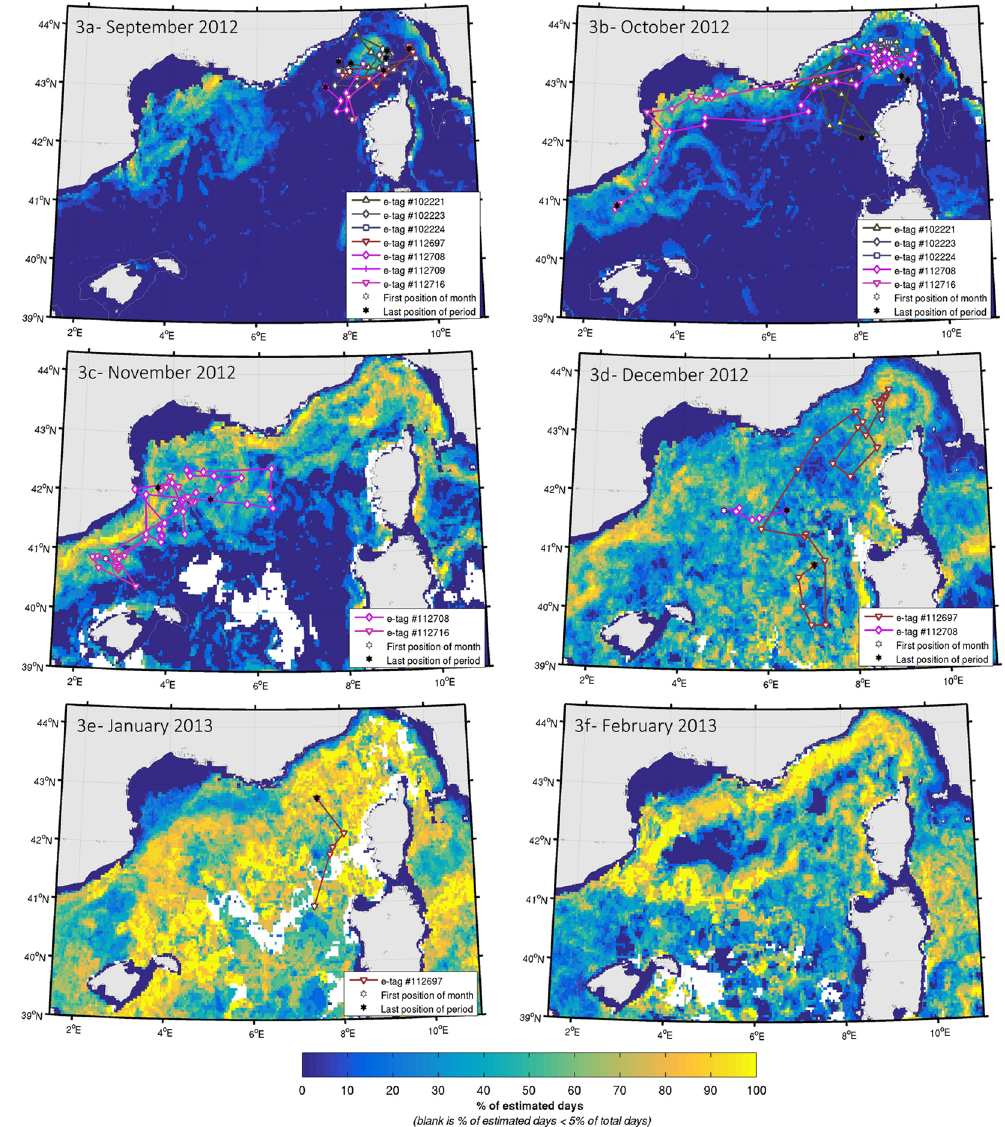
Figure 3. Seven Argos satellite derived positions overlaid on monthly mean potential feeding habitat (frequency of occurrence from September 2012 to February 2013). Note that only one position per day is shown. The potential habitat is derived from the daily detection of chlorophyll-a front, a range of surface chlorophyll-a content and a minimum water depth (see Supplementary materials for details). The 200 m depth contour is shown. The maps were prepared off-line using a commercial software package: MATLAB and Statistics Toolbox Release 2015b, The MathWorks, Inc., Natick, Massachusetts, United States (www.mathworks.